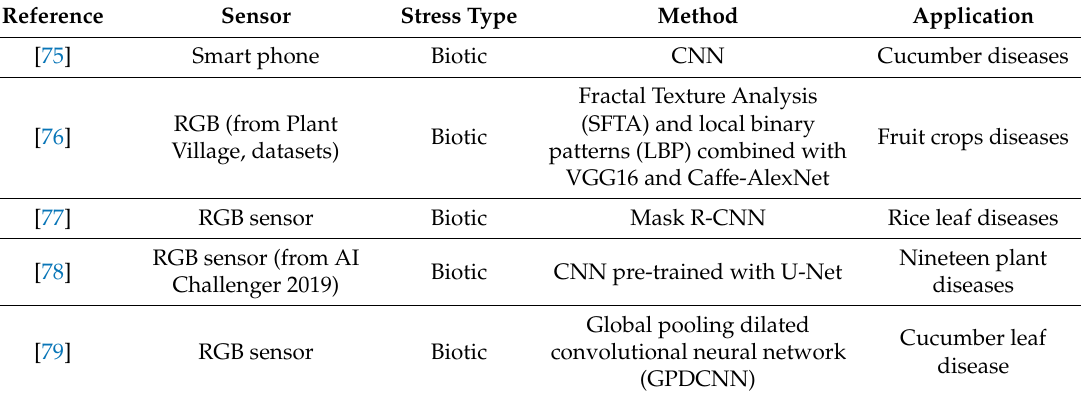
Table 2. Applications of deep learning for crop stress